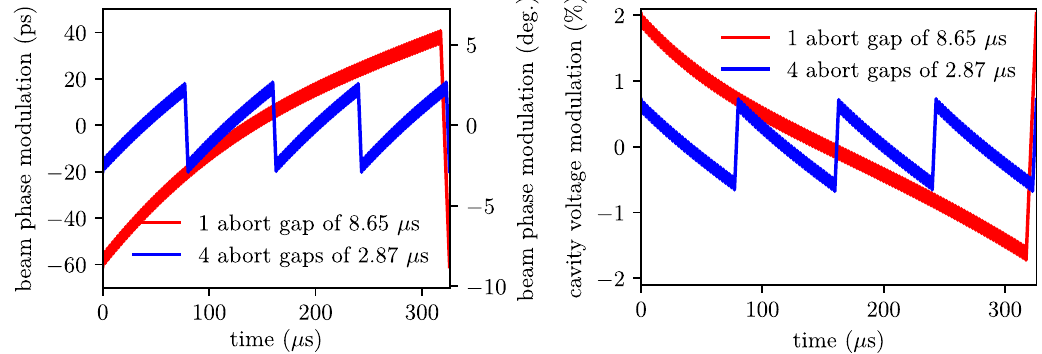
FIG. 13. Modulations of the beam phase (left) and of the cavity voltage amplitude (right) at flat top in FCC-hh for different abort gap configurations and constant generator